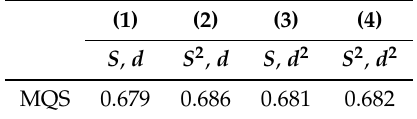
Table 2. Similarity Definitions Measured by Mean Quadratic